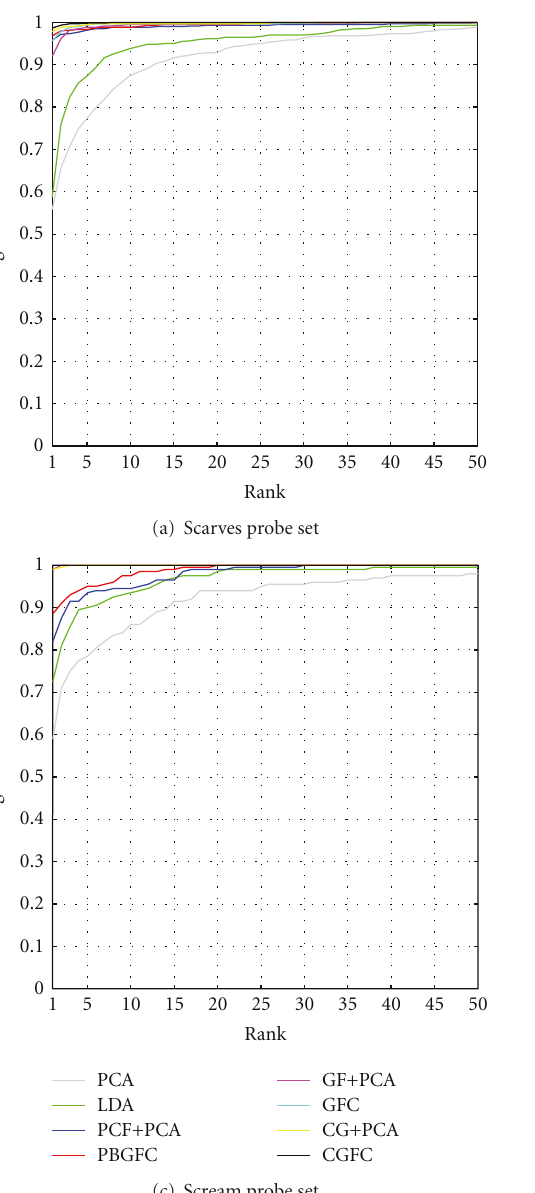
the results in form of EPC curves. To make the assessment more challenging, we introduce an artificial illumination change to the test image sets from the XM2VTS database and adopt the artificial illumination model of Sanderson and Paliwal [52] for rendition of the facial images. The model simulates di ff erent illumination conditions during the image capturing process by modifying the preprocessed facial images I ( x , y ), that